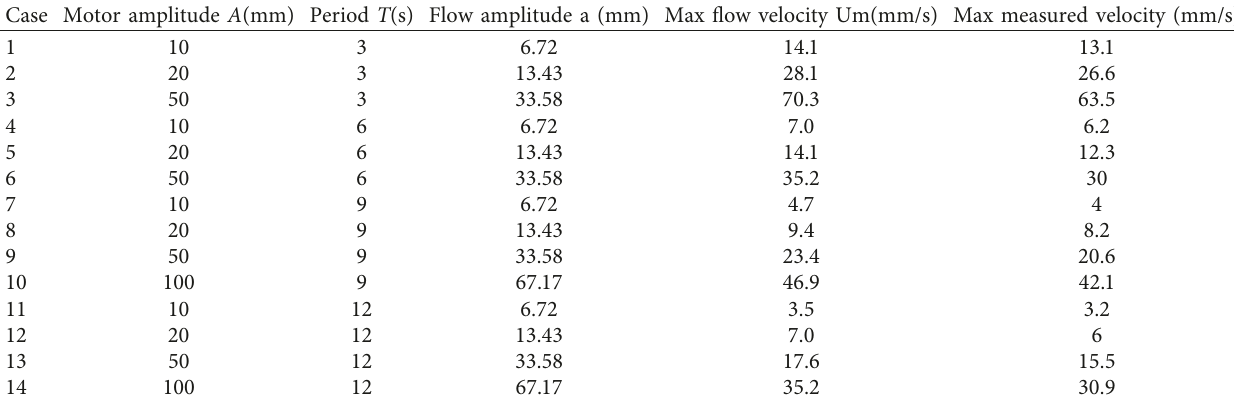
Table 3: Comparison of theoretical flow velocity and measured velocity.